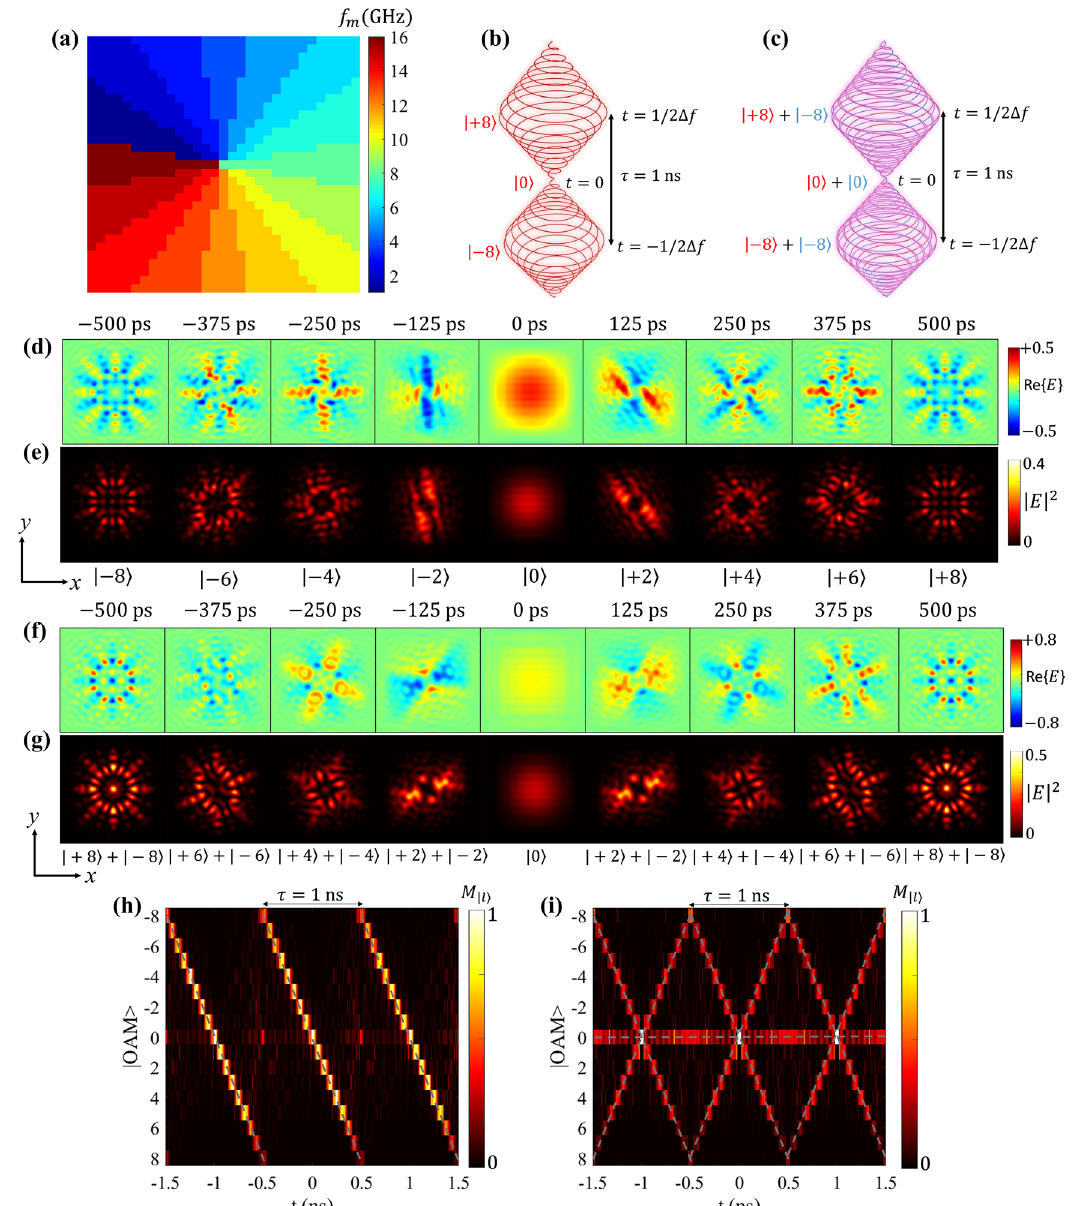
Figure 6: (a) The spatial distribution of modulation frequency across the metasurface aperture. The schematic illustration of the temporal evolutionofdynamicopticalvorticesgeneratedbyfrequencygradientTMMbiasedwith (b) thesawtooth-likemodulationwaveformoptimized forpure frequency mixingand (c) the rectangle-like waveformoptimizedforconcurrent dualfrequencygeneration. The calculated (d) realpart and (e) intensity of the re fl ected electric fi eld from the frequency gradient TMM biased with sawtooth-like waveform across the transverse x-y planeatadistanceof2 λ 0 abovethemetasurfaceatdifferentinstantoftimeswithintime-intervalof T =1nsinthesteady-state. (f) and (g) show the same as (d) and (e) for the frequency gradient TMM biased with the rectangle-like modulation waveform. The normalized spatial mode purityofthere fl ectedlightfromtheazimuthallydividedfrequencygradientTMMcalculatedasfunctionsofOAMstateandtimeforthecasesof (h) sawtooth-like waveform and (i) rectangle-like modulation t (cid:2) l / 16 Δ f at one cycle of temporal periodicity. Similar to pro fi les in this case exhibit a time-reversal symmetry due to the previous case, the results abide well with the theoret- symmetric modulation waveform with the intensity of the ical predictions showing an interference pattern of two time-domain fi eld at t (cid:2) l / 16 Δ f being the same as that at t (cid:2) − l / 16 Δ f . The perturbation of time-domain fi eld dynamic optical vortices at each instant of time. The fi eld